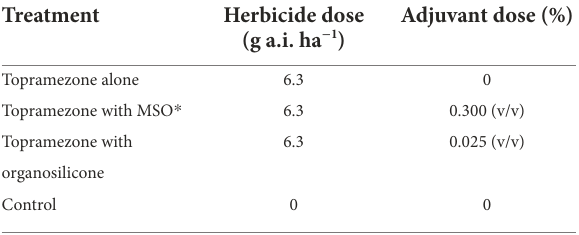
TABLE 1 Herbicide solution preparation for the